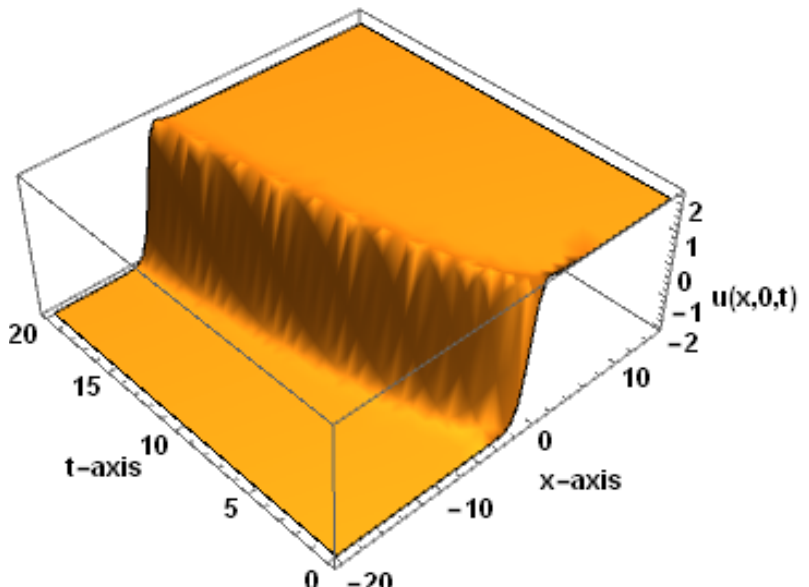
Figure 3. The 3D shape of the solution (34) implies the kink shape soliton for α = 2, β = 1, l = p = 1, λ = − 4, µ = 4, B = − 1, ρ 2 = 1, and θ = 0.5.